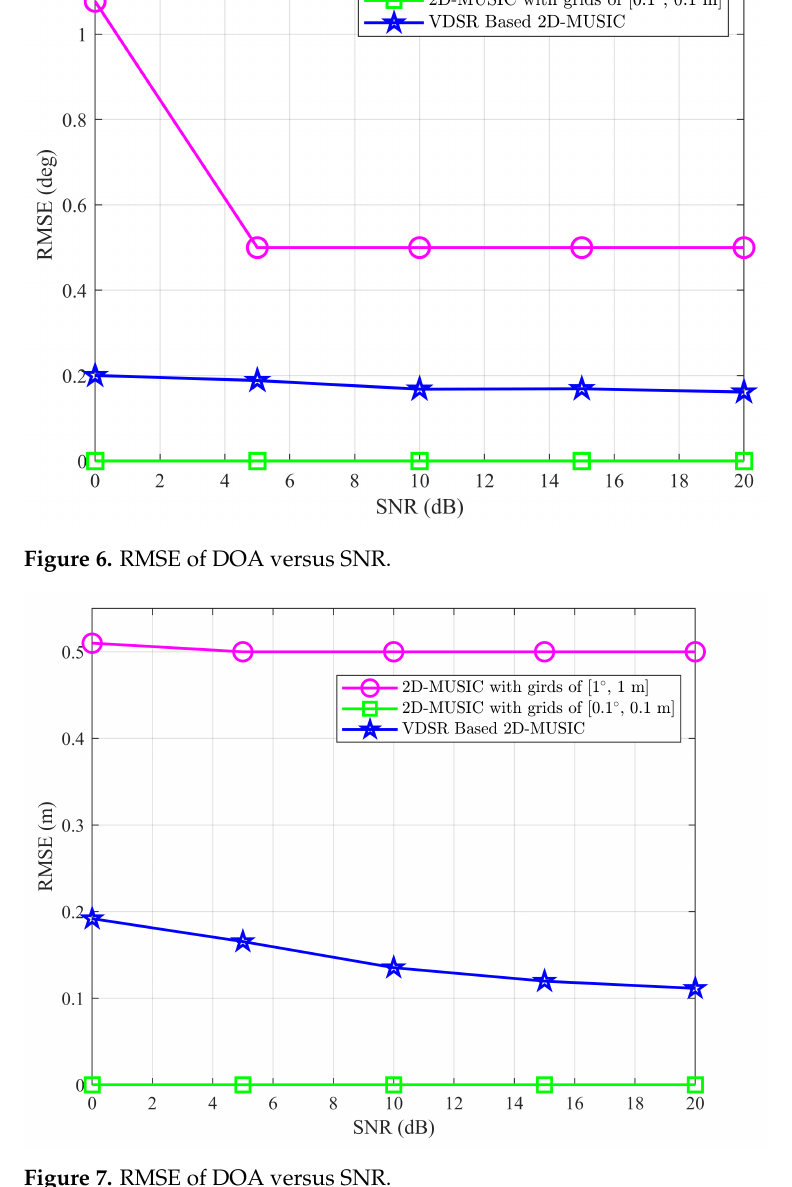
Figure 7. RMSE of DOA versus